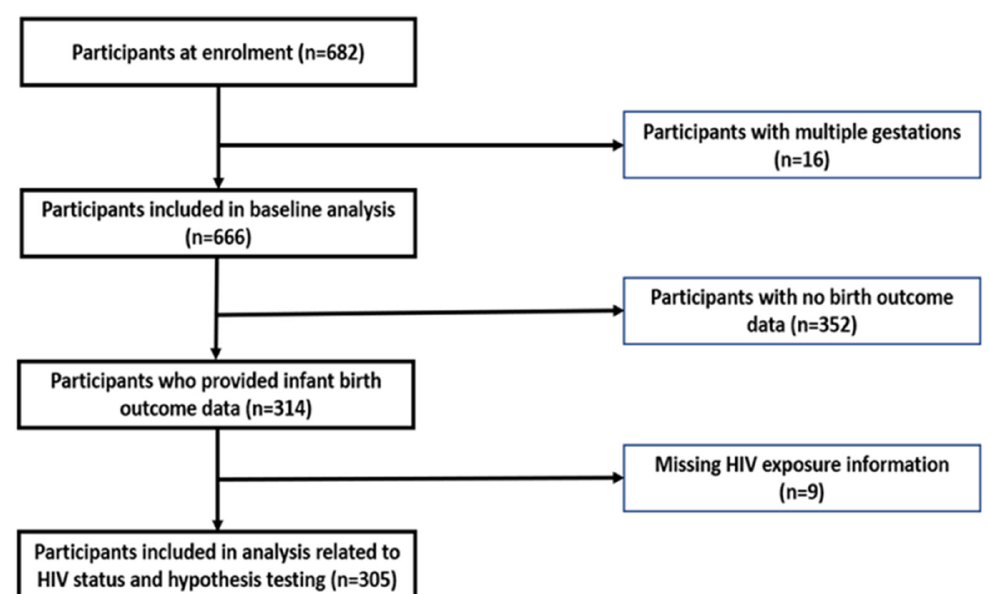
Figure 1. Flowchart of participants throughout the study.